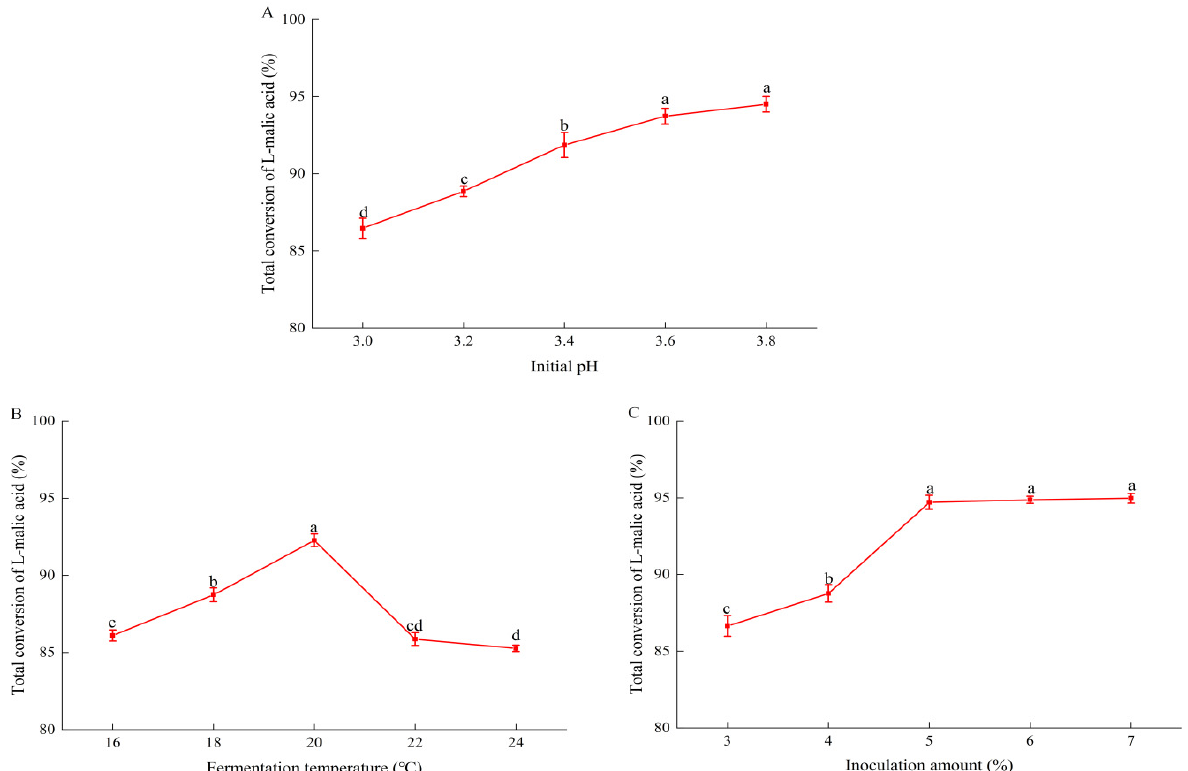
Figure 1. Effects of malolactic fermentation parameters by Oenococcus oeni strain GF-2 on total conversion of L -malic acid in pear–kiwifruit wine: ( A ) initial pH; ( B ) malolactic fermentation temperature; ( C ) amount of O. oeni inoculum. Error bars indicate the SD ( n = 3). Values with different letters are significantly different ( p < 0.05) among the samples.